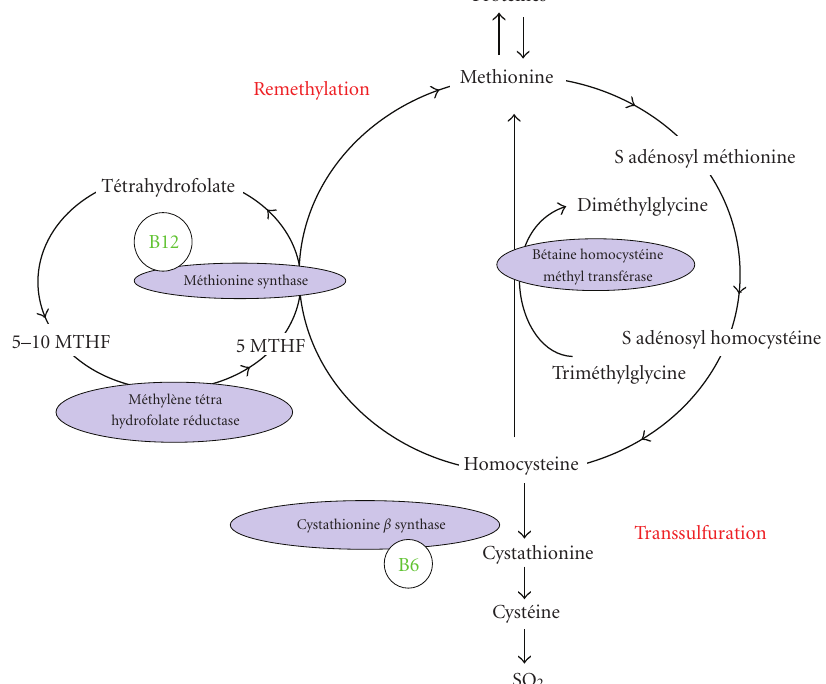
Table 1: Definitions of cobalamin (vitamin B12) deficiency [5–7]. (i) Serum cobalamin levels < 150pmol/L and clinical features and/or hematological anomalies related to cobalamin deficiency (ii) Serum cobalamin levels < 150 pmol/L ( < 200 pg/mL) on 2 separate occasions (iii) Serum cobalamin levels < 150pmol/L and total serum ho- mocysteine levels > 13 μ mol/L or methylmalonic acid levels > 0.4 μ mol/L (in the absence of renal failure and folate and vitamin B6